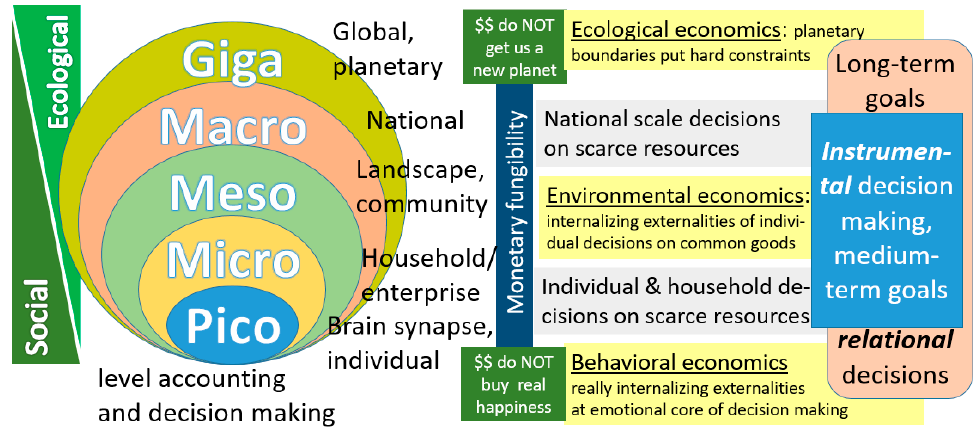
Figure 3. Linking five scales of economic analysis of social–ecological systems to two ways of deci- sion making instrumental (medium-term goal oriented) and relational [44]. making instrumental (medium-term goal oriented) and relational